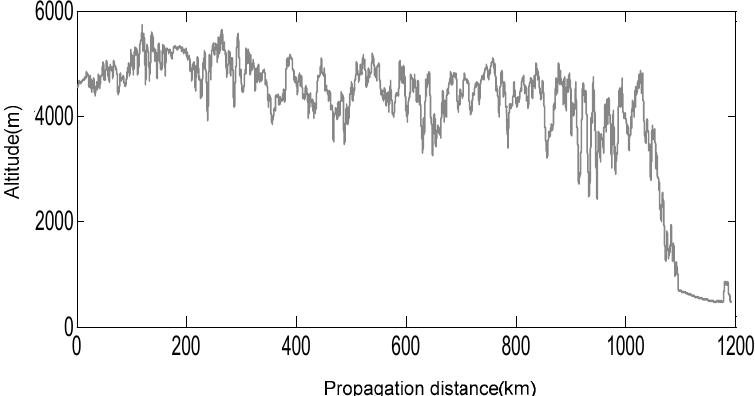
Figure 11. Landform profile of the Naqu region due east.